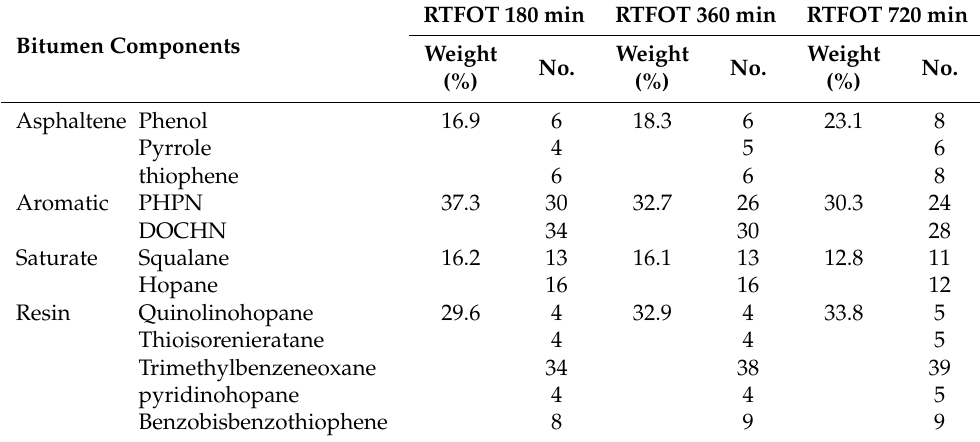
Table 4. Molecular compositions in RTFOT 180 min, RTFOT 360 min and RTFOT 720 min.